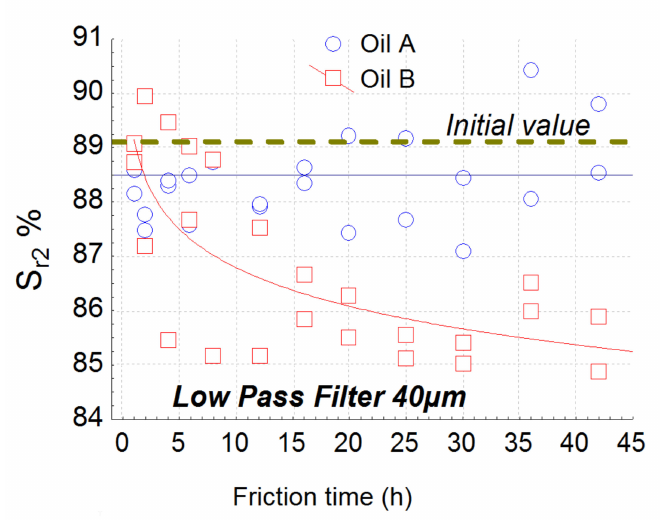
Figure 13. S r2 evolution versus friction time obtained by a low pass filter with a cuto ff of 40 µ